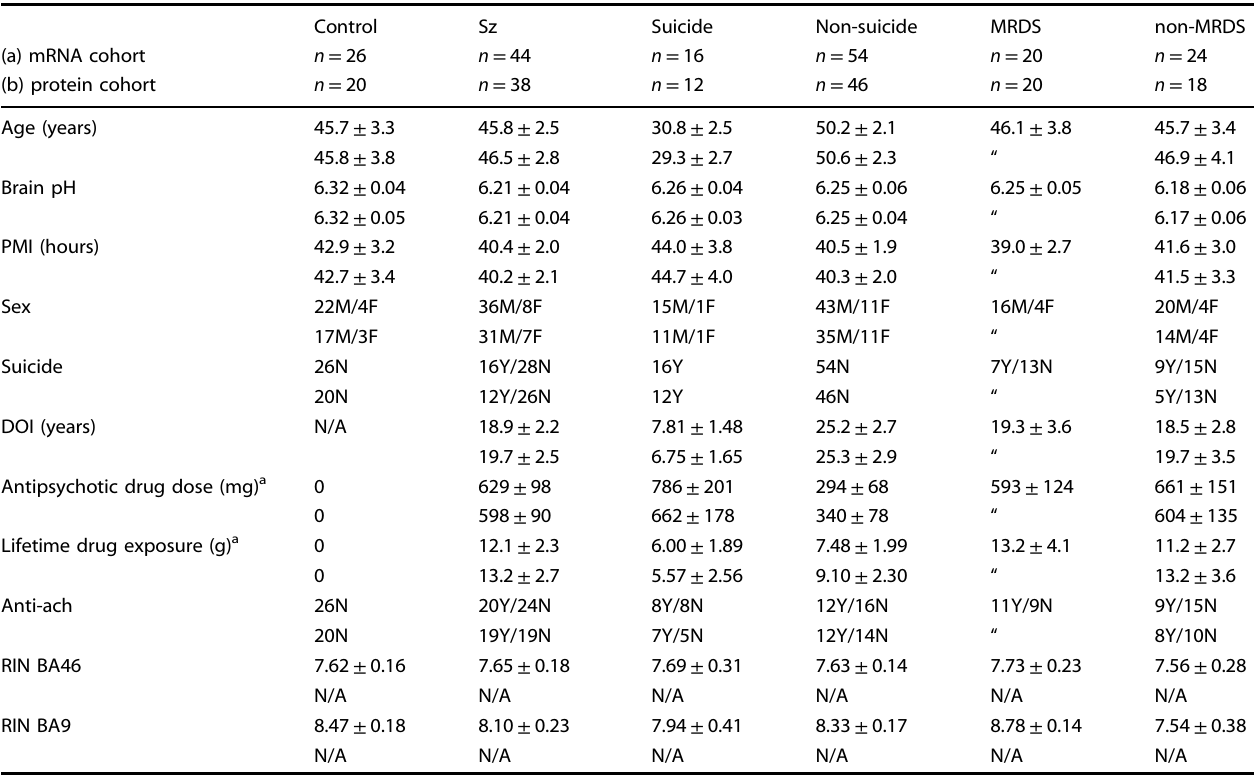
Table 1. Summary of demographic data for cohort 1 (Mean ± SEM) Control Sz Suicide